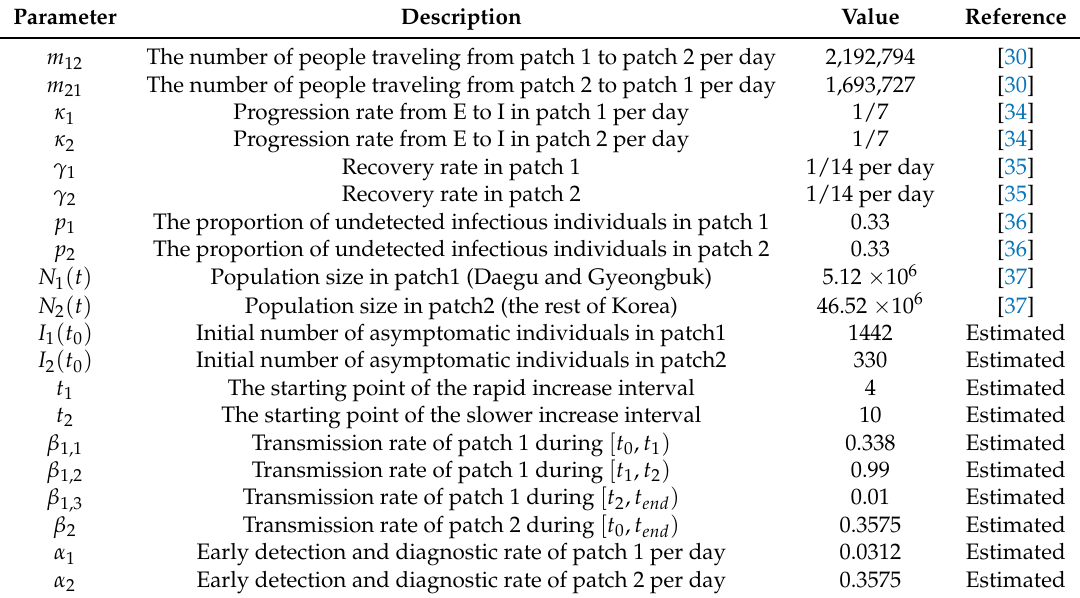
Table 2. Baseline parameter descriptions and